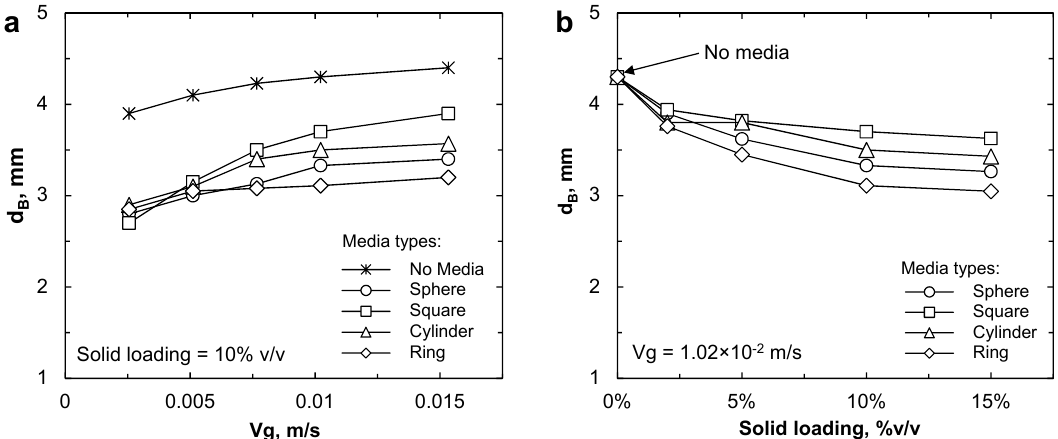
Figure 2. Mean bubble diameter (d B ) in BCR for each solid media type with: ( a ) superficial gas velocity (Vg) and ( b ) solid loading.